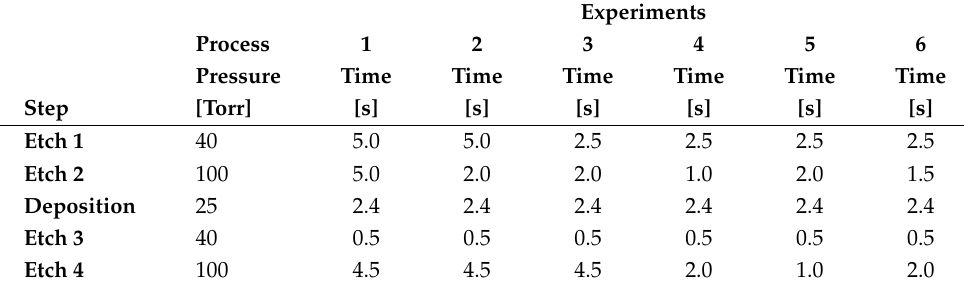
Table 2. Etch processes performed for controlled widening of the trench entrance.